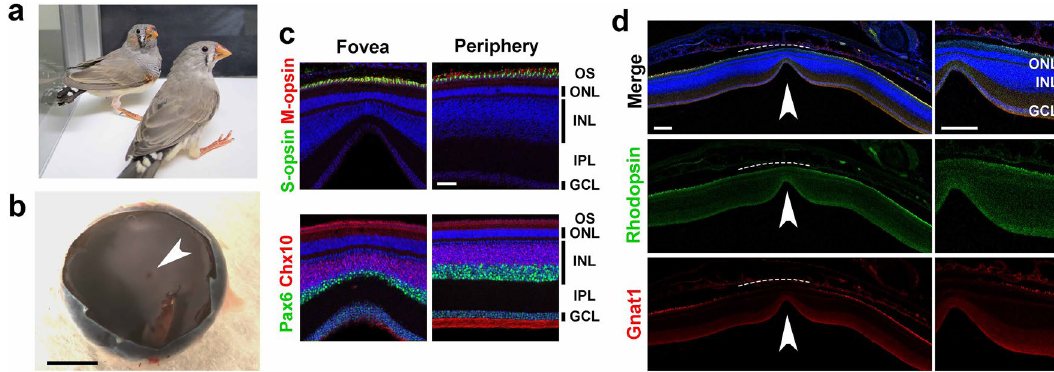
Figure 1. Immunostaining of the adult zebra finch fovea. ( a ) An image of zebra finches at P40. ( b ) A stereoscopic image of an adult zebra finch eye cup after removing the anterior part of the eye and vitreous body. The arrowhead indicates the fovea. Scale bar = 2 mm. ( c,d ) Immunostaining of retinal sections from adult zebra finches. ( c ) Retinal sections were stained with the anti-S-opsin (green) and anti-M-opsin (red) antibodies (upper panel), and the anti-Pax6 (green) and anti-Chx10 (red) antibodies (lower panel). Cell nuclei were stained with DAPI (blue). Cone photoreceptor, amacrine, ganglion and bipolar cells were present in both the fovea and the periphery in the retina. Scale bar = 50 μm. ( d ) Retinal sections were stained using anti-Rhodopsin (green) and anti-Gnat1 (red) antibodies, and DAPI (blue). Rod photoreceptor cells were present only in the